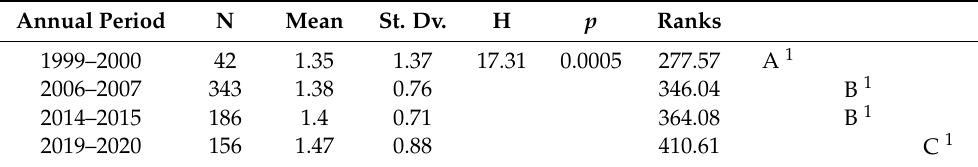
Table A8. Shape Index’s Kruskal Wallis tests between time periods for the Ituzaing ó district.